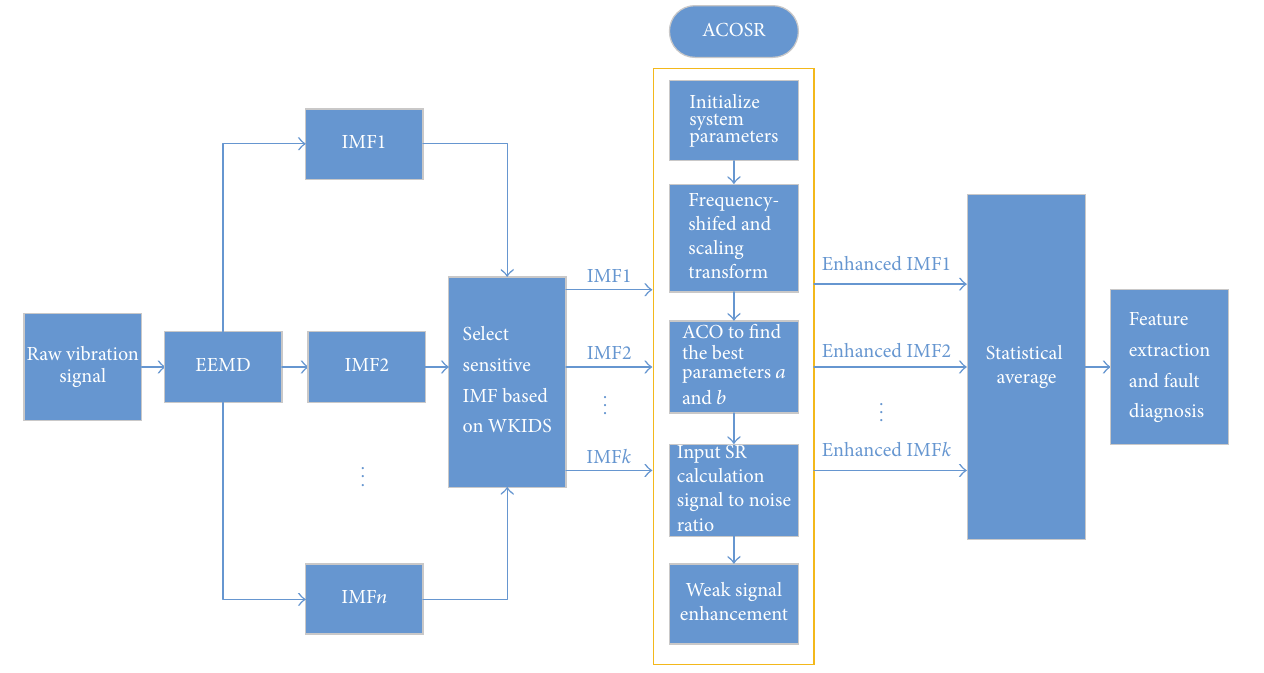
Figure 2: The flowchart of the proposed method.